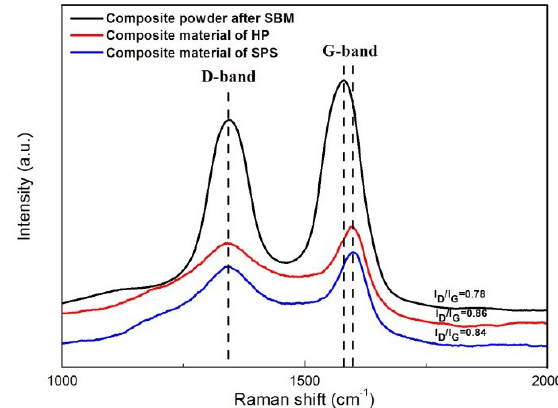
Figure 4. Raman spectra of: composite powder and composite material of HP and SPS.